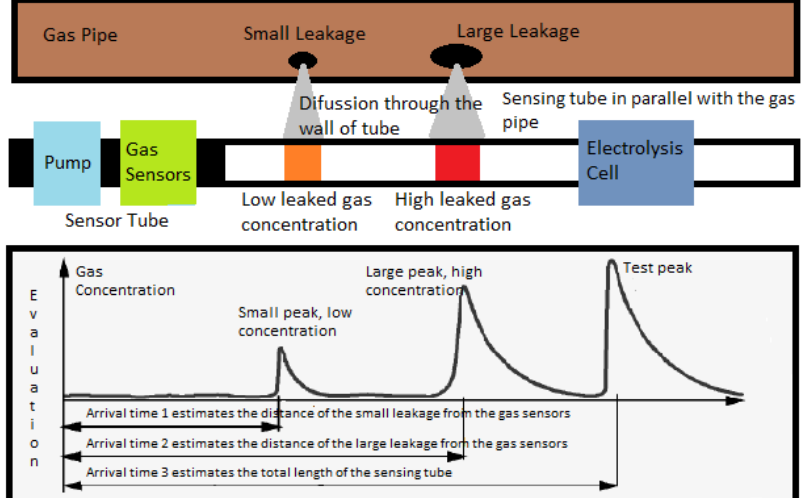
Figure 53. The schematic diagram of a vapour sensing tube by Framatome ANP Erlangen Germany for the detection of hydrogen gas leakages in a pipeline. Modified from